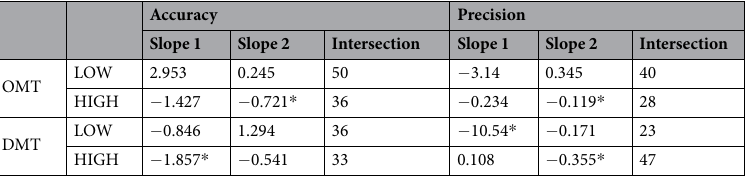
Table 2. Slopes and intersection of the of the trend lines obtained by stepwise linear regression analysis for ballistic force. Asterisk ( * ) Significant differences between slope and horizontal